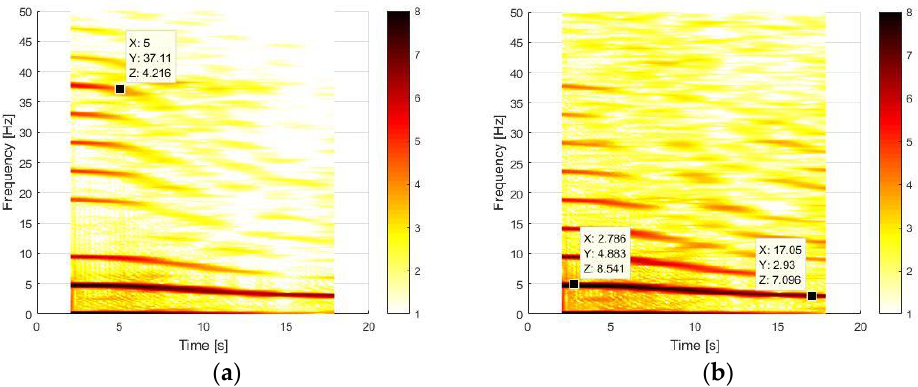
Figure 12. Time – frequency contents of CD test for P11 (contact) ( a ) and P14 (mass) ( b ) profilometer points.